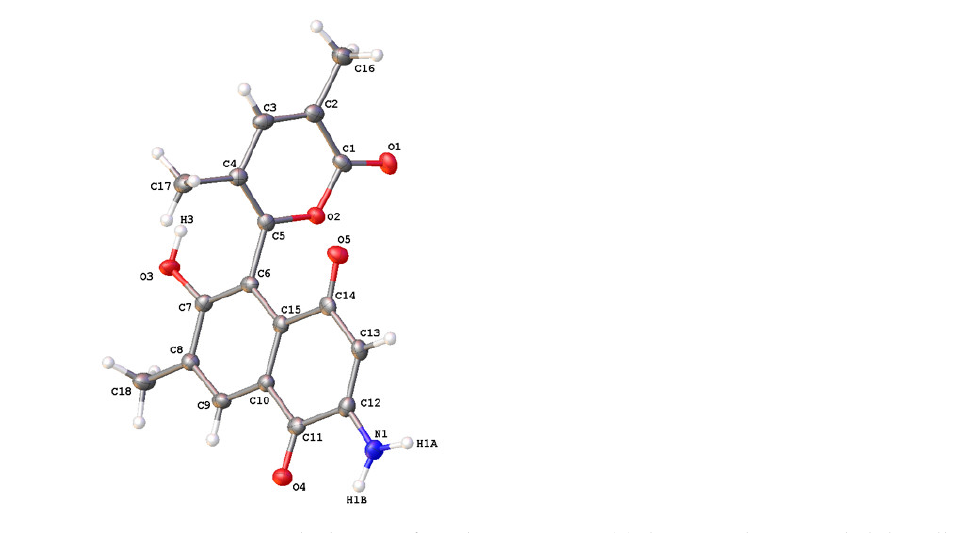
Figure 4. ORTEP-style diagram for salinisporamine ( 5 ) drawn with 50% probability ellipsoids. Table 2. NMR data for salinisporamine ( 5 ) recorded in DMSO- d 6 at 600 MHz.